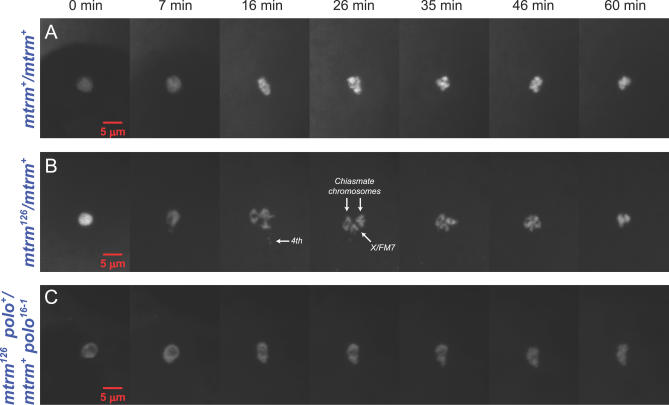

mtrm Causes the Individualization of Bivalents after NEBStage 12 oocytes were injected with Oli-green to visualize karyosomes. After this injection, we analyzed the change in karyosome structure during NEB using live imaging. Time frames from NEB (time 0) are shown for: (A) FM7/X; mtrm+/mtrm+ for control; (B) FM7/X; mtrm126/mtrm+; and (C) FM7/X; mtrm126 polo+/mtrm+ polo16–1 oocytes (see also Videos S1–S3). In control oocytes, the karyosome stays condensed after NEB and then becomes elongated at about 13 min, presumably as a consequence of the chromosomes establishing proper centromere co-orientation. As noted in the text, almost all control oocytes (8/9) exhibited a karyosome in which chromosomes are tightly associated. In the remaining case, three bivalents could be distinguished but were still physically associated. However, in FM7/X; mtrm126/mtrm+ oocytes, the 4
th chromosomes are separated from a single mass of chromatin at 6–8 min after NEB, and then X, 2nd and 3rd chromosomes start to spread out. At approximately 16 min after NEB, they are individualized into three obvious and fully separate bivalents.Individualized chromosomes begin to re-condense around 46 min and form a single mass. Indeed, the majority (11/15) of those oocytes that underwent bivalent individualization eventually formed bipolar spindles with the chiasmate chromosomes properly balanced on the metaphase plate (see also Figure 4 of Harris et al. [9]). Thus the karyosome maintenance defect induced by heterozygosity for mtrm does not permanently impair the progression of prometaphase. Finally, the karyosome maintenance defect induced by heterozygosity for mtrm was suppressed by reducing the dosage of the polo+ gene.As noted in the text, 10 of the 13 FM7/X; mtrm126 polo+/mtrm+ polo16–1 oocytes maintained the karyosome as a single mass throughout the process of spindle assembly. The three remaining cases may be described as follows: (1) the karyosome dissolved into three clearly distinguishable bivalents, but this oocyte did not ever succeed in forming a bipolar spindle; (2) the three major bivalents could be distinguished but did not physically separate; and (3) in an oocyte that may have been leaking or damaged, the bivalents individualized at about 8 min after the initiation of spindle assembly, but their morphology was abnormally stretched and thread-like. 7 min later, these chromosomes began to fragment into much smaller pieces, which led to the assembly of a spindle with at least five and possibly more poles. It seems likely that this case reflects simply the fragility of the karyosome, even in polo16–1/polo+ suppressed oocytes, rather than the defect observed in FM7/X; mtrm126/mtrm oocytes that are wild type for polo.